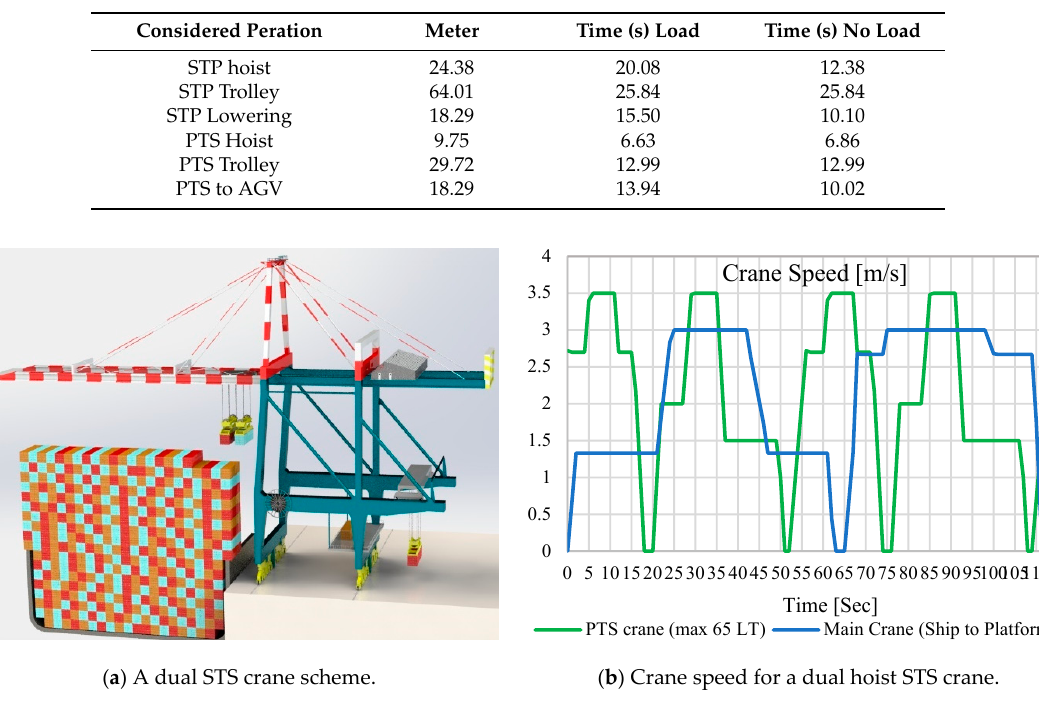
Figure 5. STS Crane scheme and reference speed.